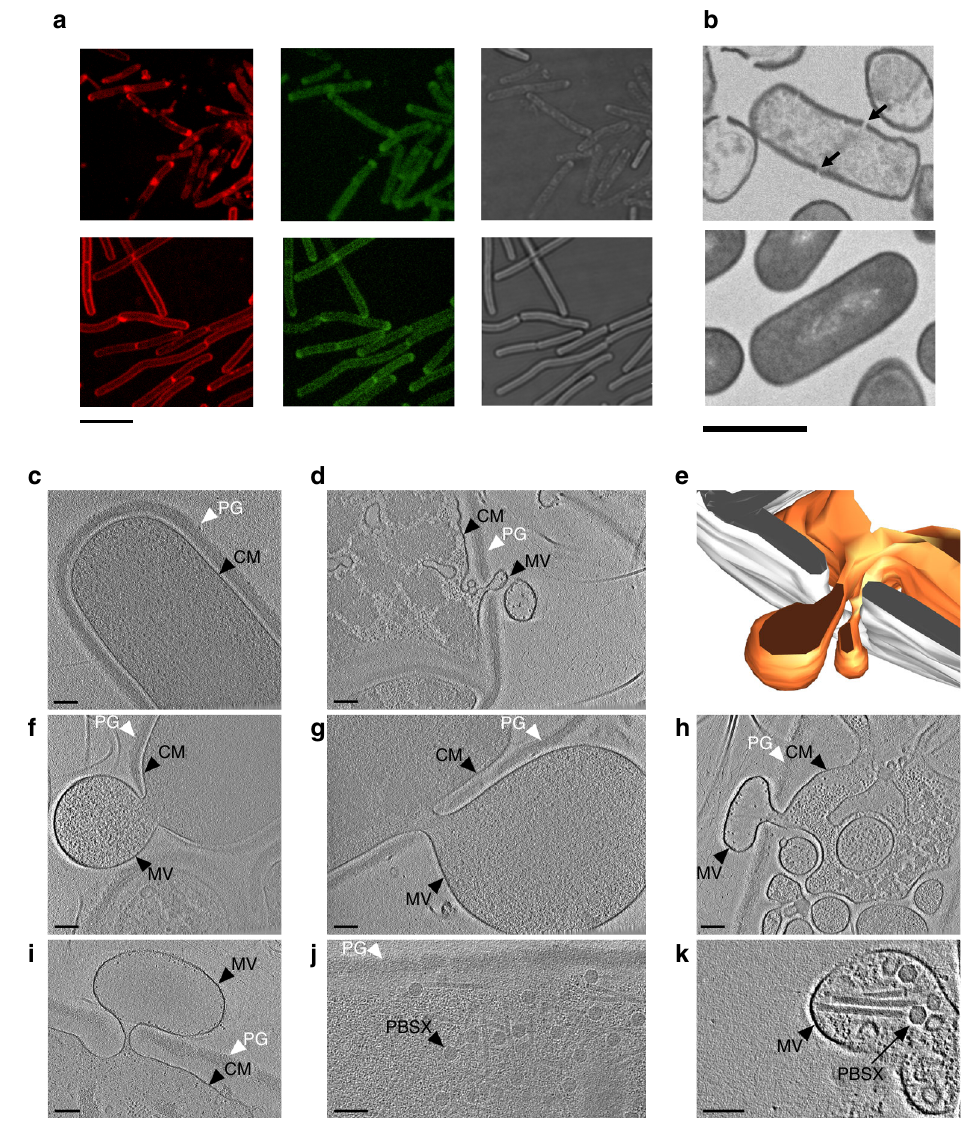
Fig. 3 The activity of the PBSX endolysin creates holes in the bacterial cell wall. a Staining of the PG with FDL in cells expressing the holin – endolysin genes and in uninduced control cells. Upper panel shows strain 168 (P xylA -xhlAB-xlyA ), in which the holin – endolysin genes were expressed; the lower panel shows the control strain 168 (P xylA ). Membranes were stained with FM4-64 ( red , left ) and the PG was stained with FDL ( green , central ). Corresponding bright fi eld images are shown in the right panel . Scale bar , 5 μ m. b Thin section of induced B. subtilis 168 (P xylA -xhlAB-xlyA ) cells ( upper panel ) and of the control strain 168 (P xylA ) ( lower panel ). Arrows indicate holes in the bacterial cell wall. Scale bar , 1 μ m. c – k ECT images of different Bacillus Δ ponA strains. c Uninduced B. subtilis Δ ponA (P xylA -xhlAB-xlyA ) cells have an intact peptidoglycan (PG) layer and cytoplasmic membrane (CM) and a dense cytoplasm. d – h Induced cells extrude MVs through holes in the PG layer. We also observed cells with lowered cytoplasmic densities that harbored intracellular vesicles ( h ). i – k Likewise, cells of a MMC-induced B. subtilis Δ ponA culture showed MV formation ( i ) in addition to phage particles (PBSX) inside cells ( j ) and sometimes within extracellular MVs ( k ). Shown are 1.38 nm ( c , f , h , k ), 6.9 nm ( g ), 11.86 nm ( i ), 29.64 nm ( j ) thick slices through cryotomograms and a model ( e ) of the cell shown in d . White , peptidoglycan; orange , cytoplasmic membrane. Scale bars , 100